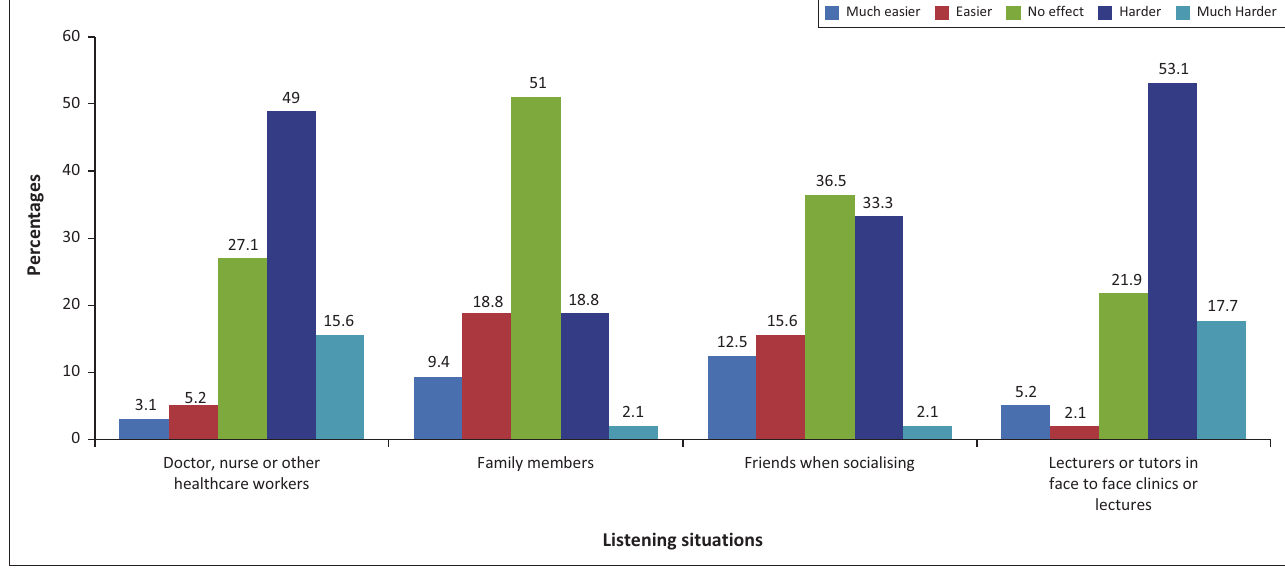
FIGURE 4: Impact of masks on the ability to hear and understand by the listening situation ( n = 96).